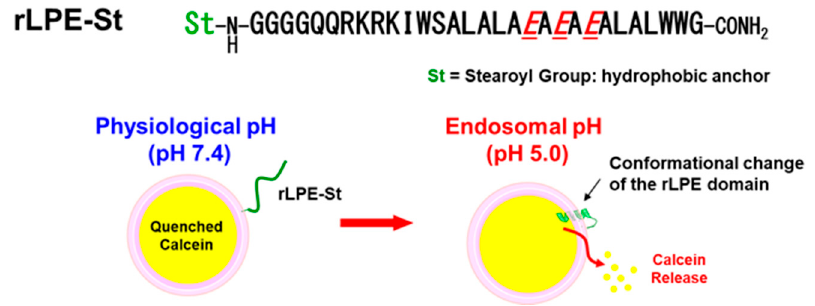
Figure 3. Schematic illustration of the pH-selective self-lytic liposome system by the use of the acidic-pH-selective membrane lytic polypeptide conjugate (rLPE-St).